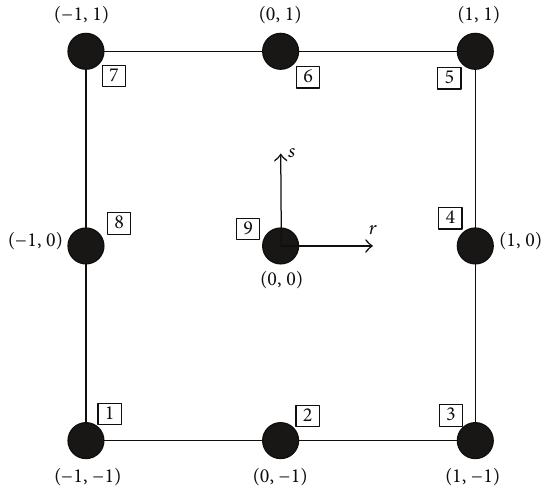
Figure 5: Cross-sectional L9 element in the natural plane.